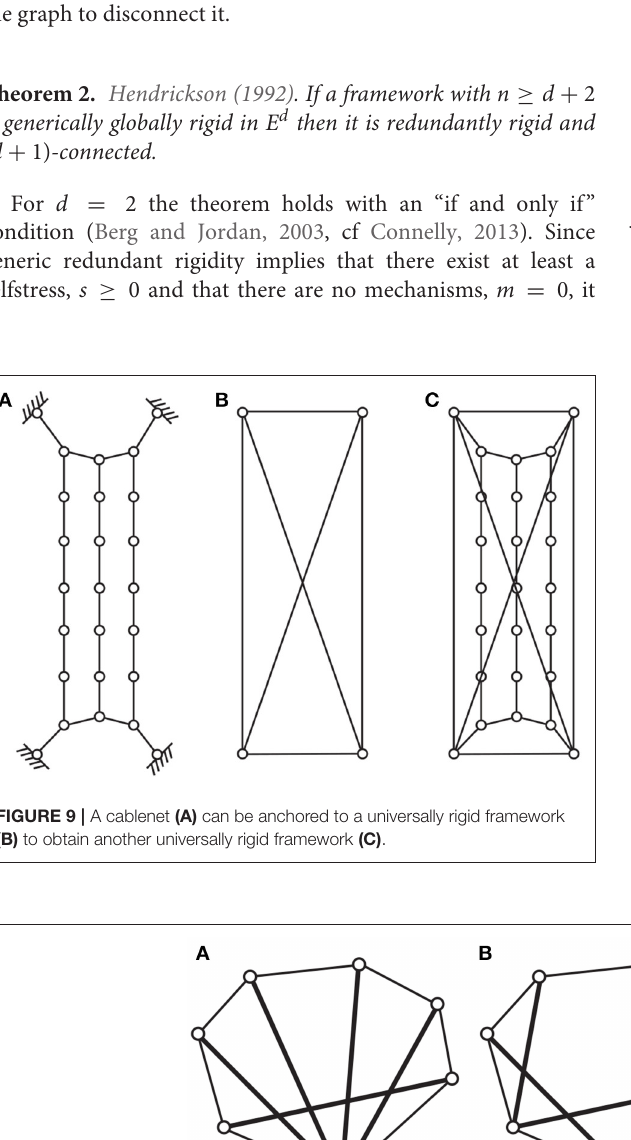
Frontiers in Materials |